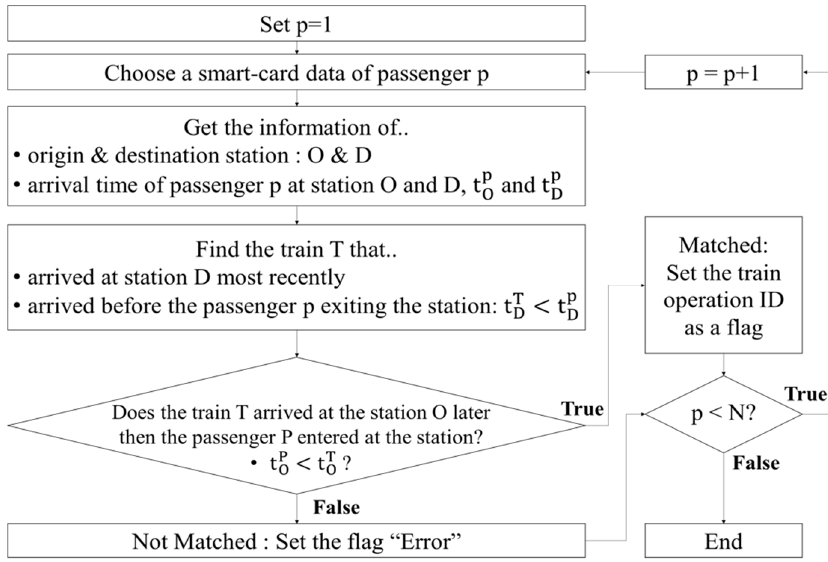
Figure 2. Smart card-based passenger information matching process against the real-time train operation data.